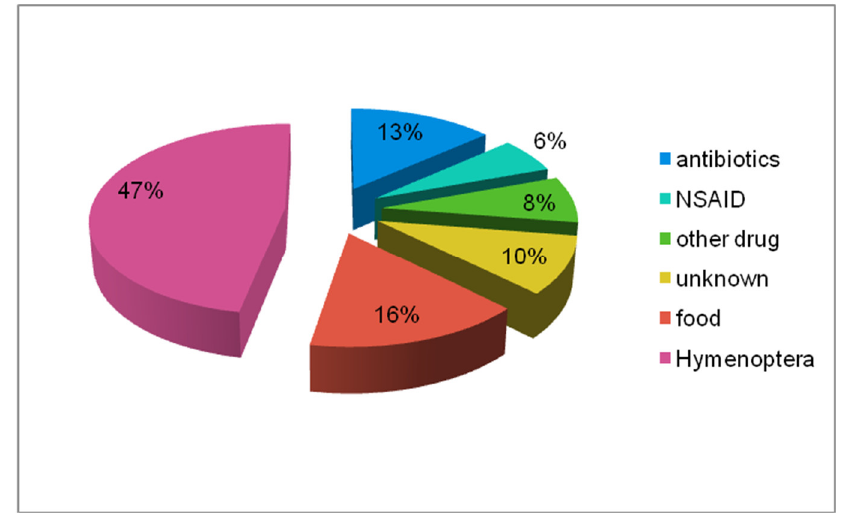
Figure 11. Triggers of anaphylaxis in the children’s group (%).